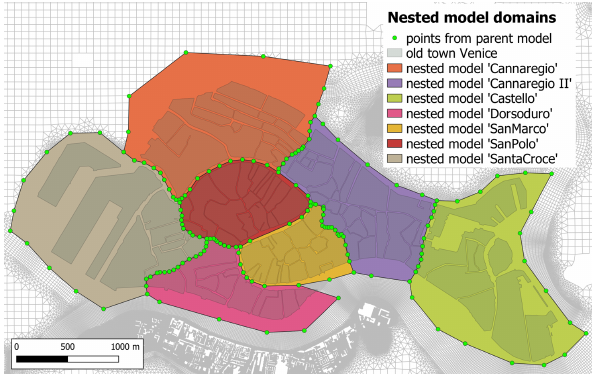
Figure 3. Nested model domains with observation points from par- ent model used as boundary